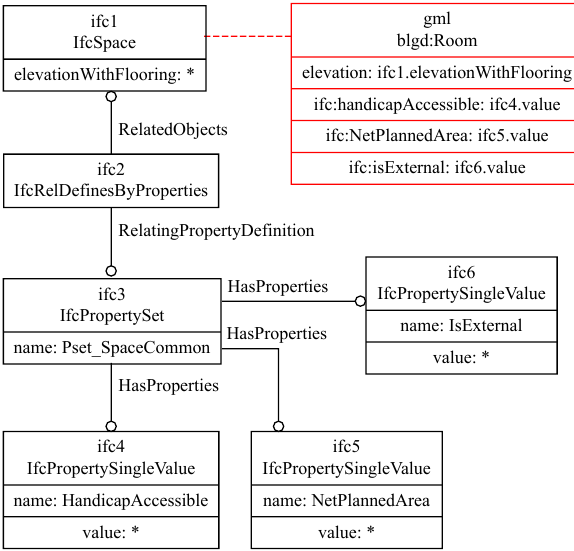
Figure 13. Sample property and attribute extraction for rooms